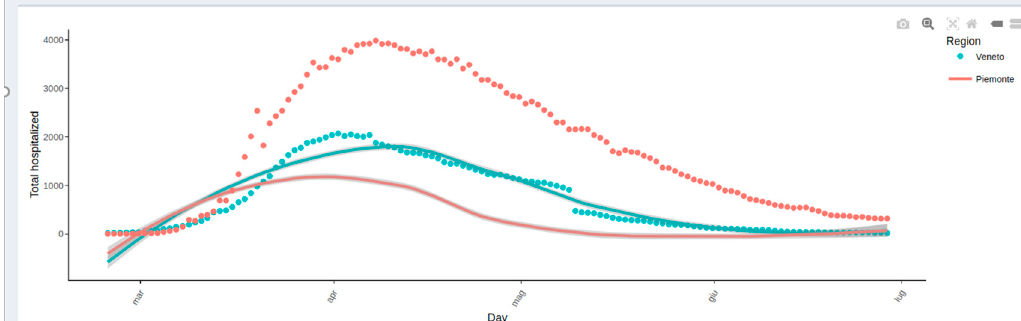
Figure 2. One example (web page screenshot) of the content of the Highlights section (namely, the impact of testing on hospitalization) as displayed in the main body of the COVID-19ita application. The figure represents the Veneto model applied to the Piedmont data without taking into account the information regarding the number of swabs performed. In Piedmont (red curve) the number of expected hospitalizations according to the model should be similar to that of Veneto (green curve), but it differs considerably from the observed data (red dots).